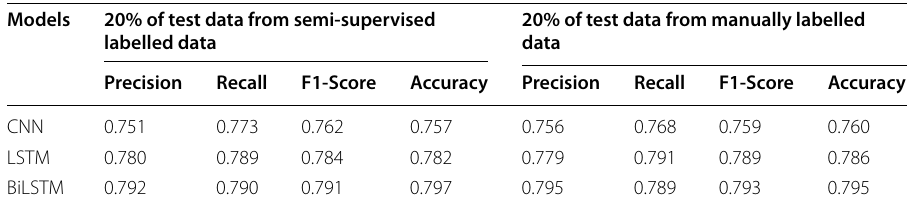
Table 7 Precision, recall and F1-scores of deep learning algorithms Models